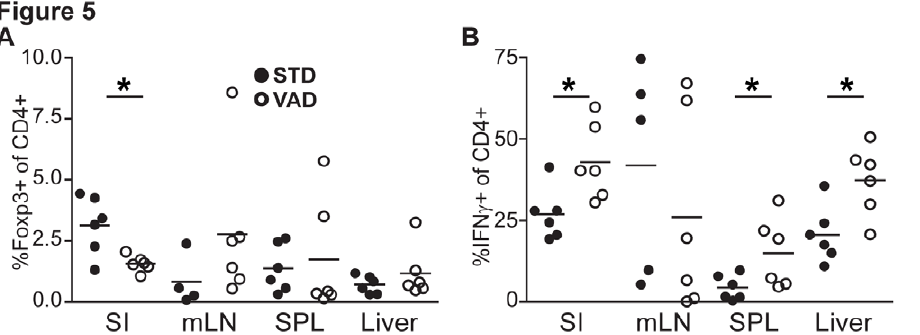
Figure 5. Vitamin A deficiency of recipient mice leads to increased Th1 cells and decreased FoxP3 + Treg cells during GvHD. STD or VAD recipient mice were analyzed for CD4 + T cell polarization status in SPL, mLN, liver and small intestine (SI) at day 21 after transplantation. ( A ) Each bar represents the percentage of FoxP3 + CD4 + T cells of CD4 + T cells isolated from the indicated organ. ( B ) Each bar represents the percentage of IFN- c + CD4 + T cells of CD4 + T cells isolated from the indicated organ.